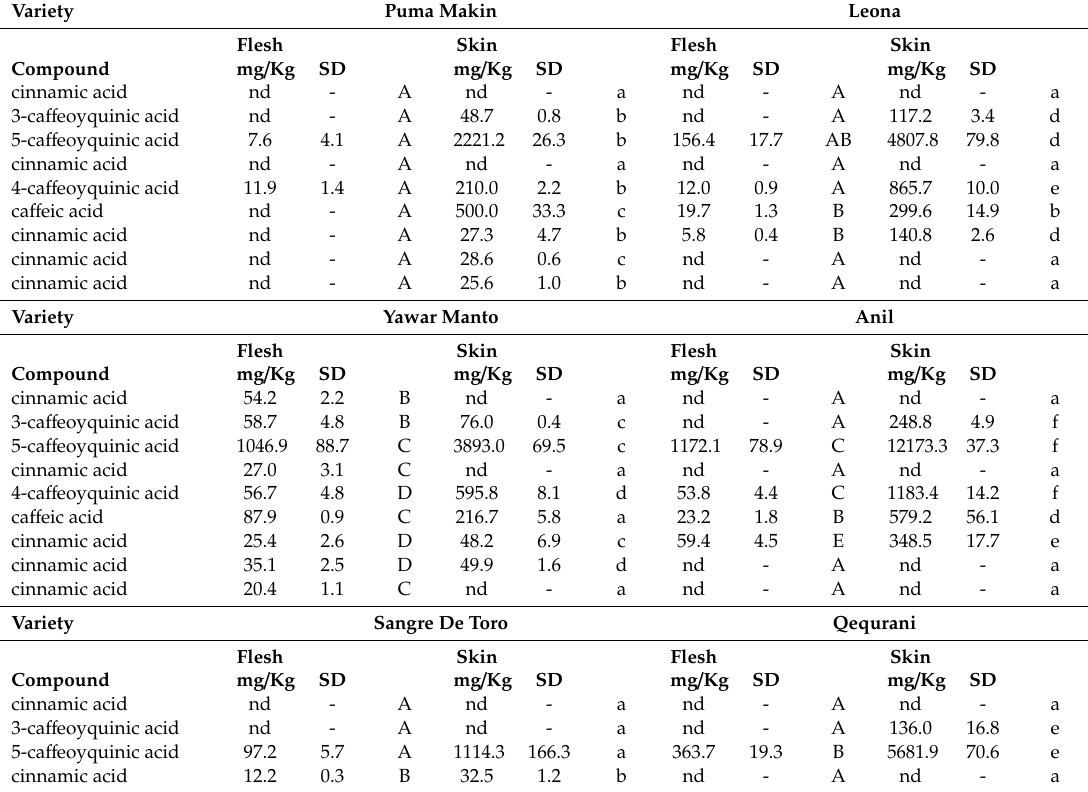
Table 5. Phenolic acids in the flesh and skin of the di ff erent tubers expressed as mg / Kg DW. Data are expressed as mean ± standard deviation. Di ff erent letters indicate significant di ff erences among varieties for each compound ( p < 0.05) for the flesh tissue (uppercase letters) and for the skin tissue (lowercase